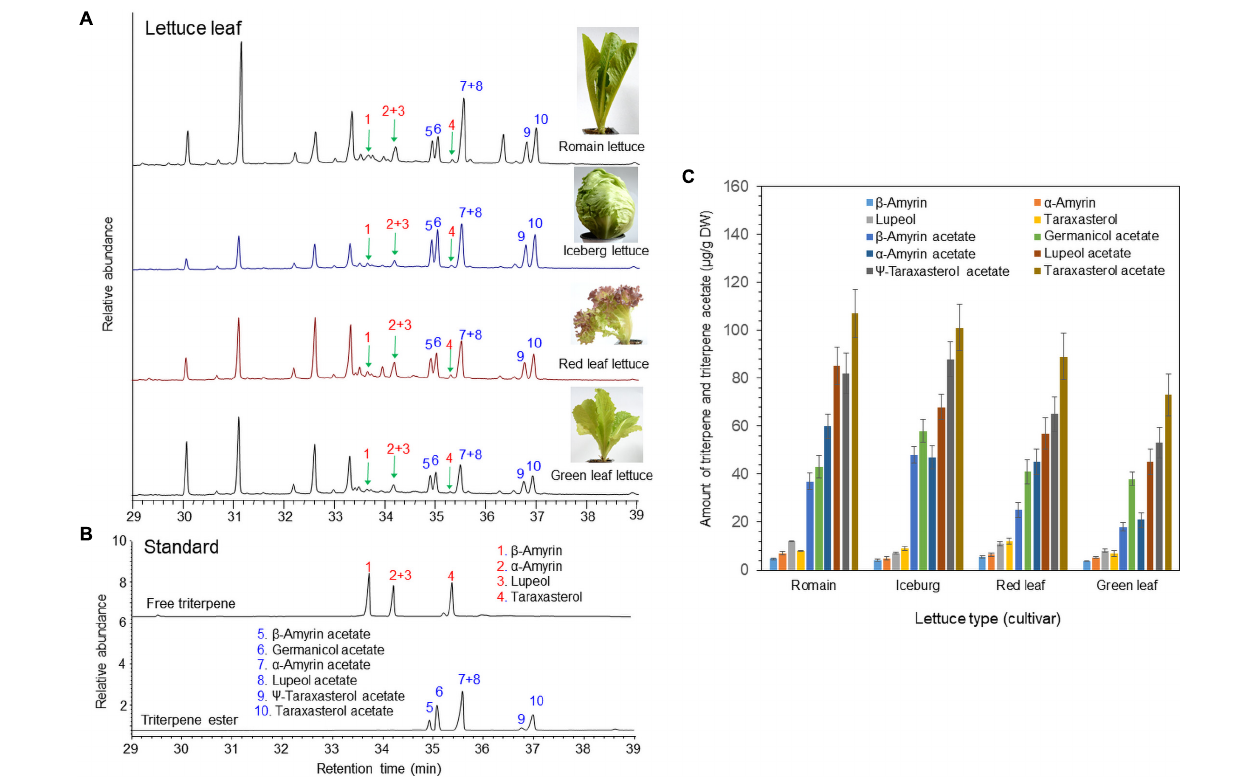
FIGURE 1 | Identification of free triterpenes and triterpene esters in the leaves of four lettuce cultivars by gas chromatography–mass spectrometry (GC/MS) analysis. (A) Total ion chromatogram (TIC) of leaf extracts from four different lettuce cultivars. (B) TIC of authentic triterpene and triterpene ester standards. (C) Analysis of triterpenes and triterpene acetates in leaves of four lettuce